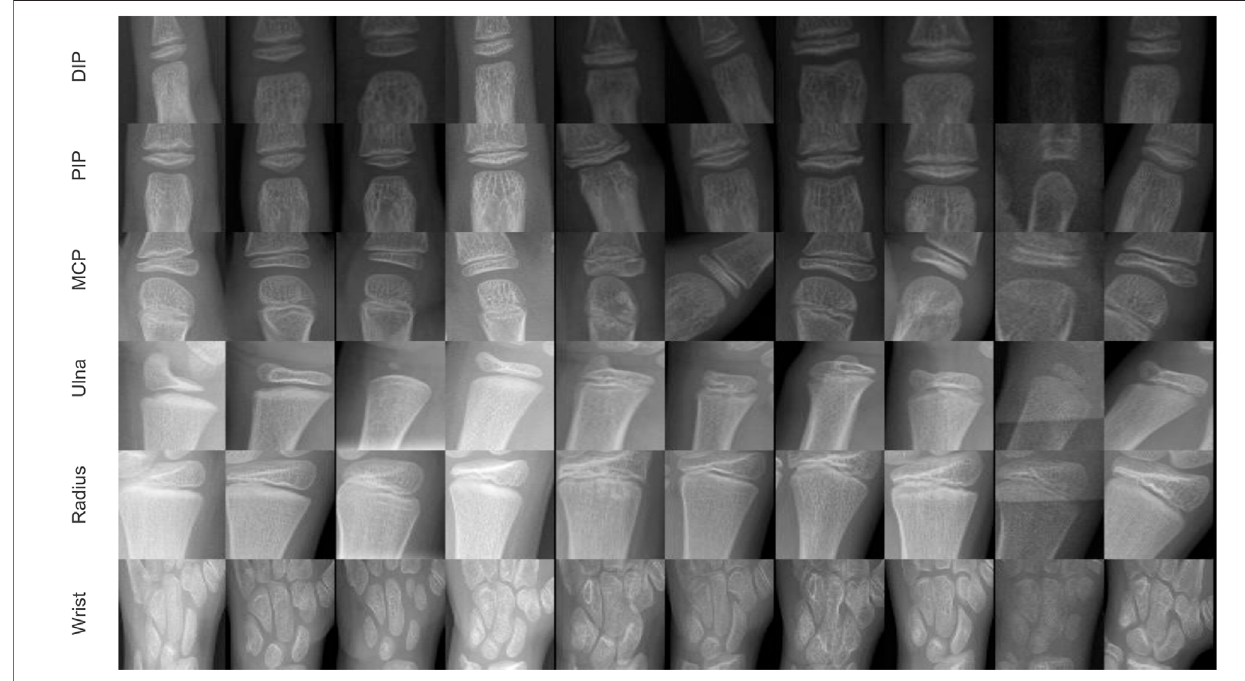
FIGURE 5 | Extracted annotated ROIs in the testing data.